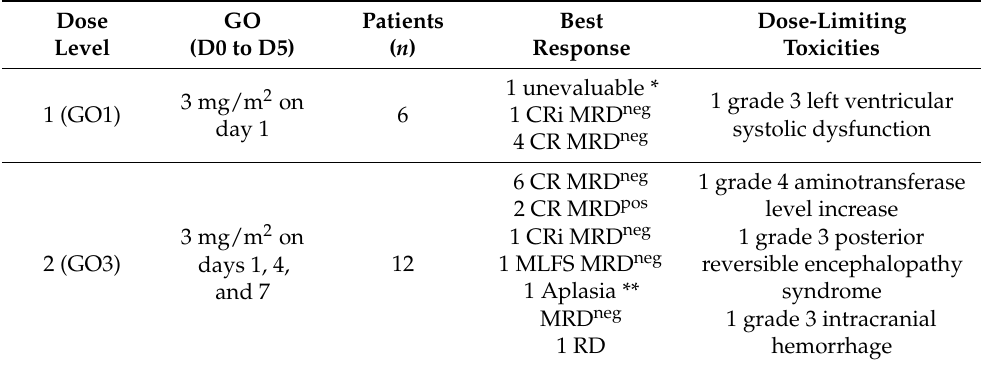
Table 2. Dose escalation scheme, best responses, and dose-limiting toxicities during phase 1, n =